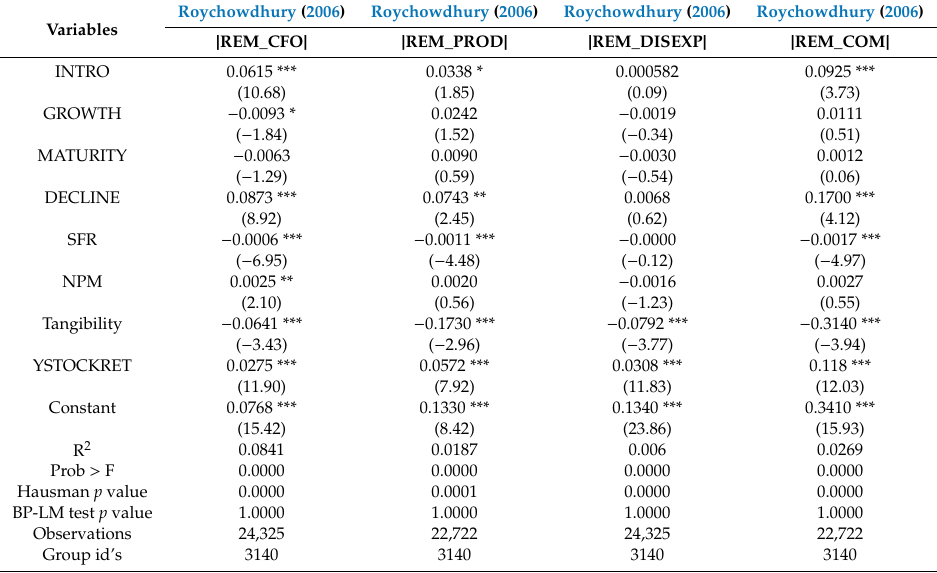
Table 7. H2 Estimations (CLC stages and REM